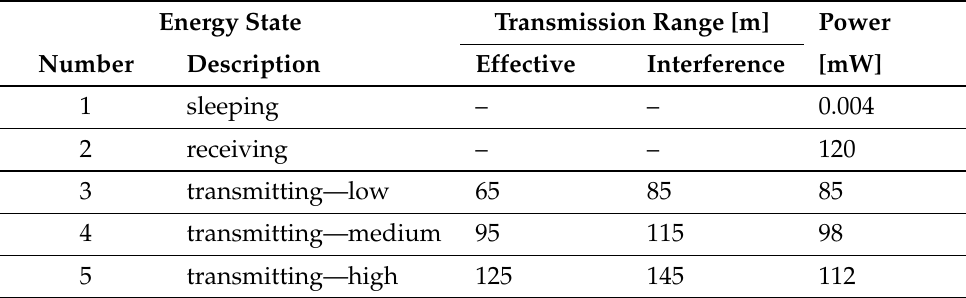
Table 2. Energy states and ranges of sensor nodes used in